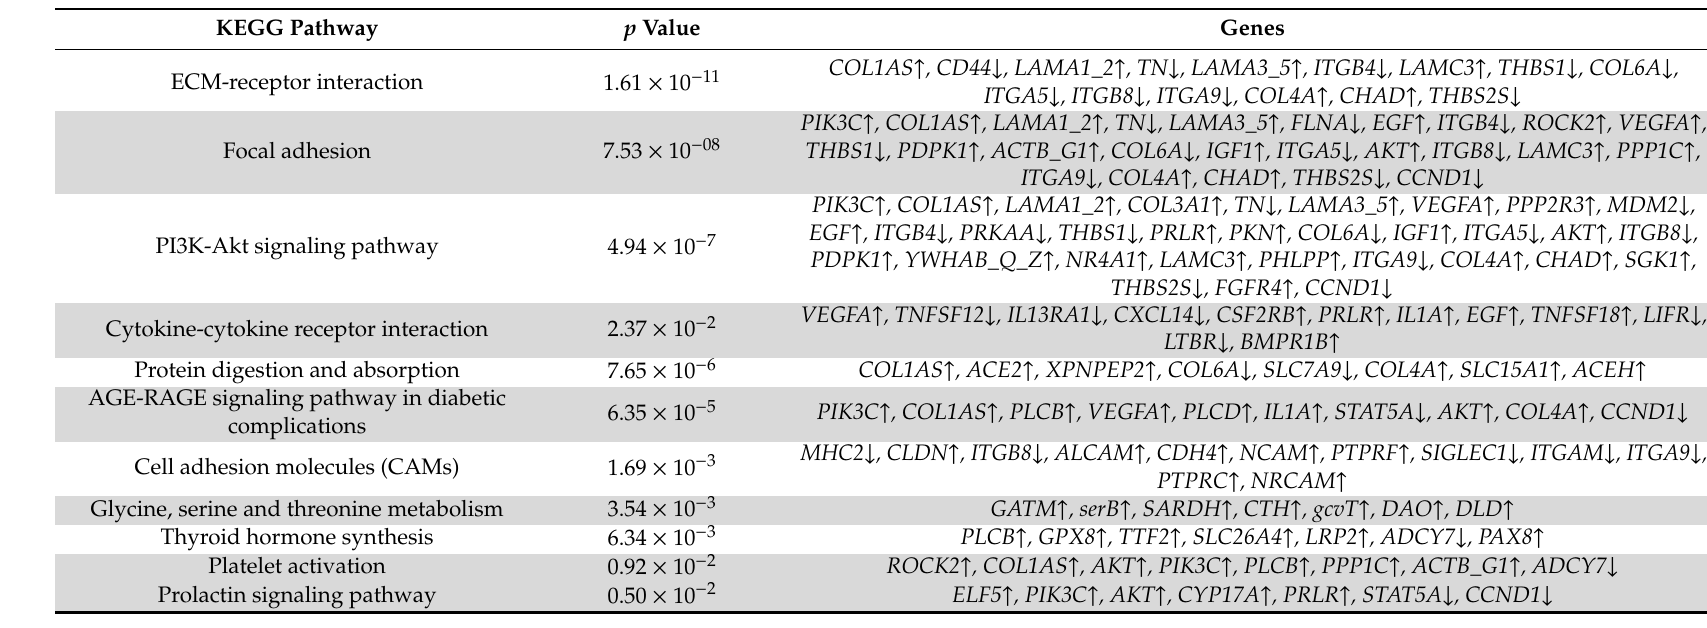
Table 4. Most enriched pathways in the activated uterus vs. the diapause uterus at p <